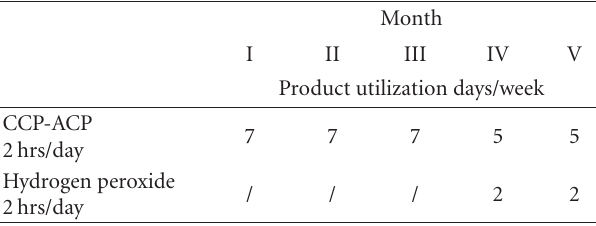
Table 1: Scheme of the combined use of Casein Phosphopeptide- Amorphous Calcium Phosphate (CCP-ACP) and hydrogen perox-